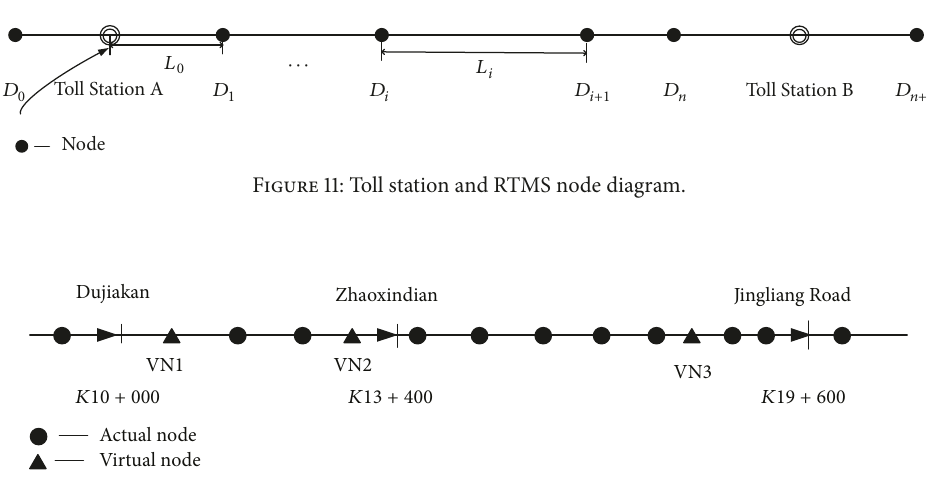
Figure 12: Relative position of detectors and toll stations. “ 󳶳 ” refers to the driving direction; “ | ” refers to the toll station.